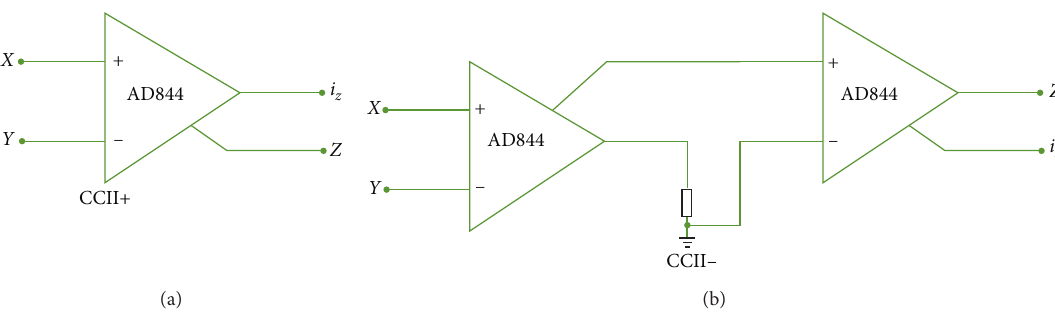
Figure 8: Implementation of the in-phase current conveyor (a) and the reverse-phase current conveyor